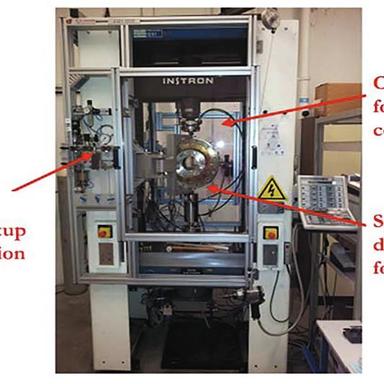
COMPTINN' multi-physical test machine @PPRIME Institute.